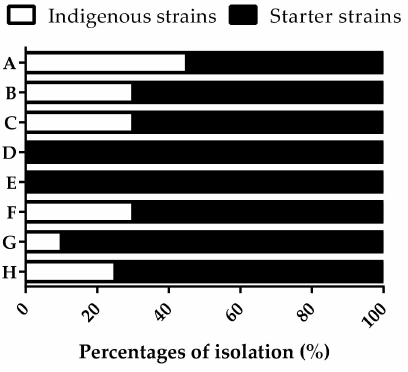
Figure 1. Isolation frequency expressed as percentages of the indigenous and starter S. cerevisiae strains in different spontaneous fermentations carried out at industrial scale at the beginning (A, B, C, D) and the end of the same vintage (E, F, G,